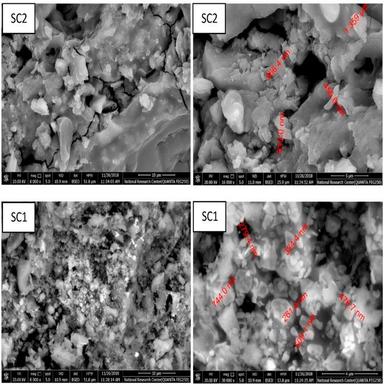
SEM images (different magnifications) of SiO2@C powders prepared from rice husk.